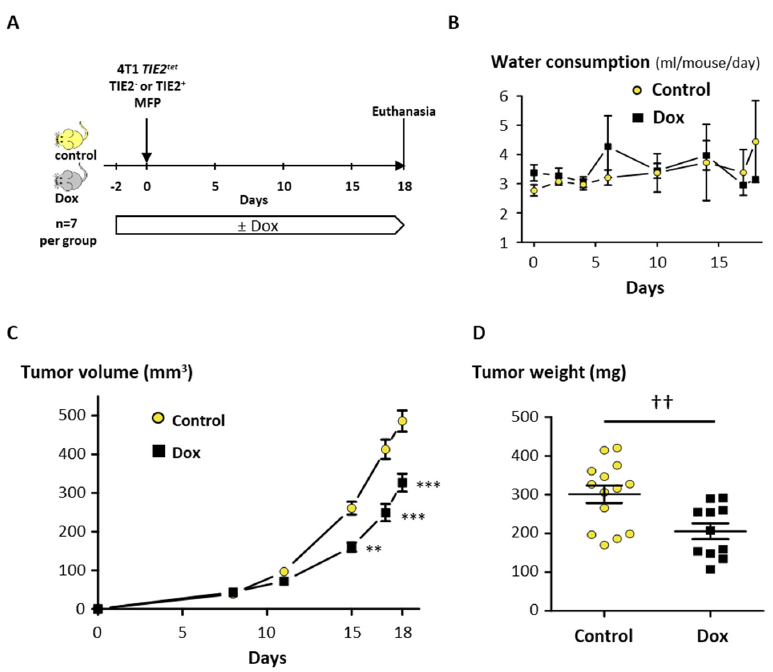
Figure 7. TIE2 reduces the growth of orthotopic 4T1 TIE2 tet tumors. ( A ) 4T1 TIE2 tet cells were cultured in the presence or absence of doxycycline for 2 days before being inoculated bilaterally, in the 4th mammary fat pad of mice receiving or not doxycycline in their drinking water (n = 7 per group). ( B ) Water consumption and ( C ) tumor volume were measured throughout the experiment, and ( D ) the weight of excised tumors was measured at the time of the euthanasia. Results are represented as the average ± SEM. ** p < 0.01 and *** p < 0.001 vs. control mice using a two-way ANOVA with Bonferroni